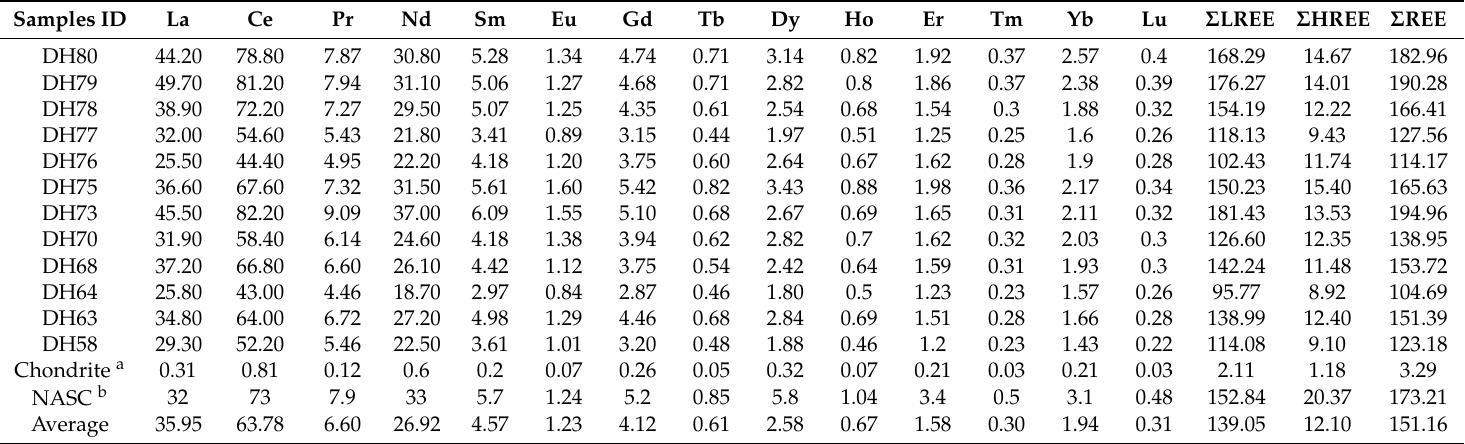
Table 2. Rare earth elements concentration in oil shale samples (unit in ppm).